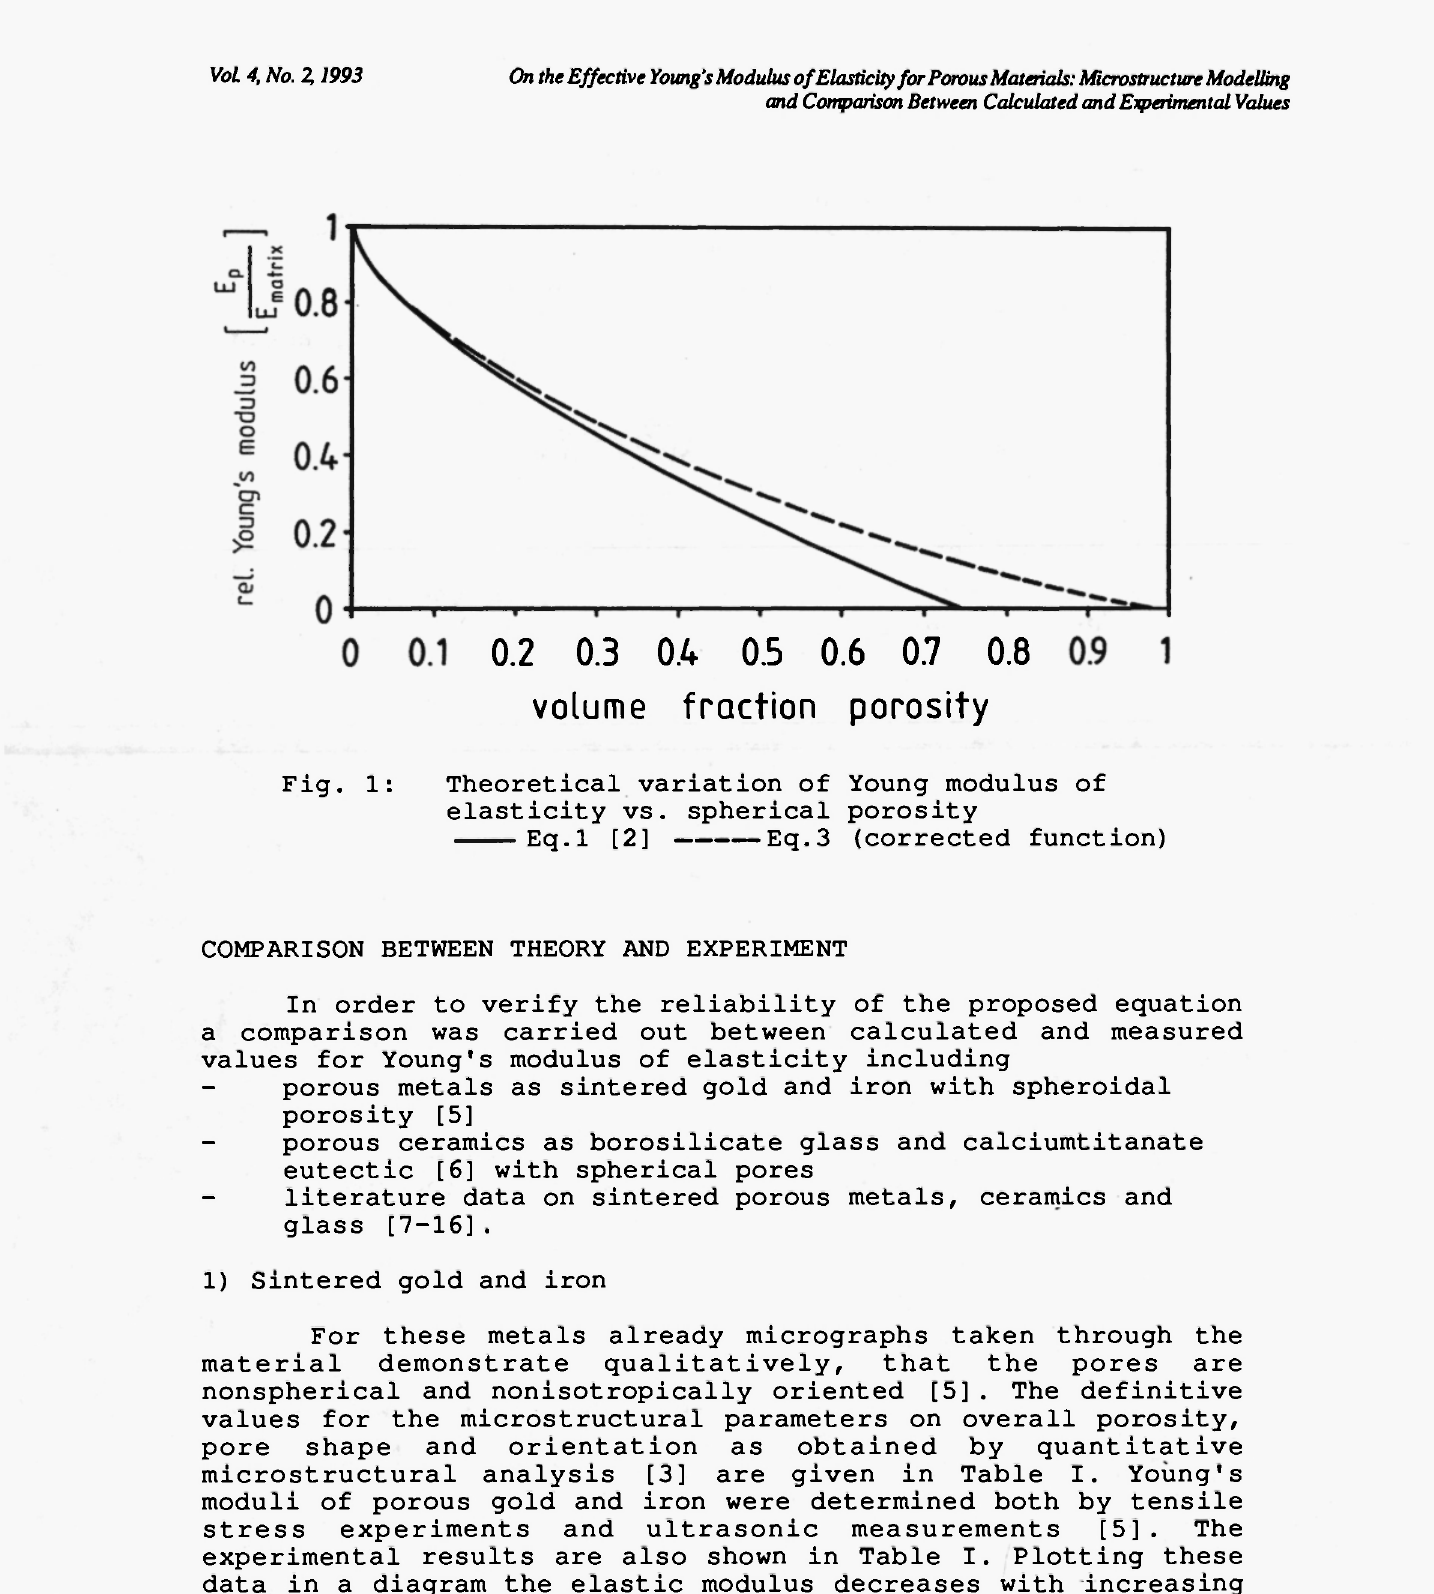
0.2 0.3 0.4 0.5 0.6 0.7 0.8 volume f r a c t i on p o r o s i ty Fig. 1: Theoretical variation of Young modulus of elasticity vs. spherical porosity Eq.l [2] Eq.3 (corrected function)